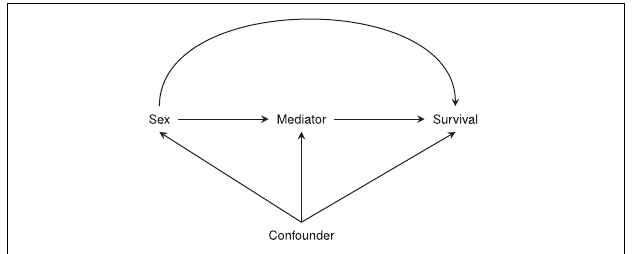
FIGURE 1 | Diagram differentiating confounding from mediation.